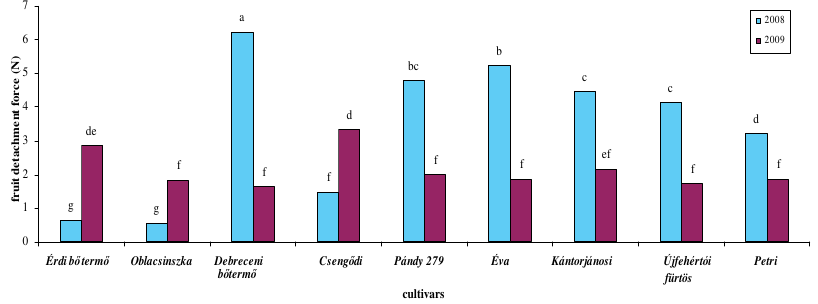
Figure 1. Fruit detachment force of the studied sour cherry cultivars in tow years (2008 & 2009). Different letters indicate significant differences between treatments (P